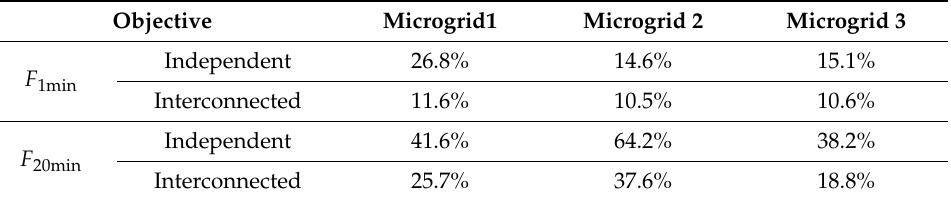
Table 1. Power fluctuation rate comparison in different schemes without ESS. Objective